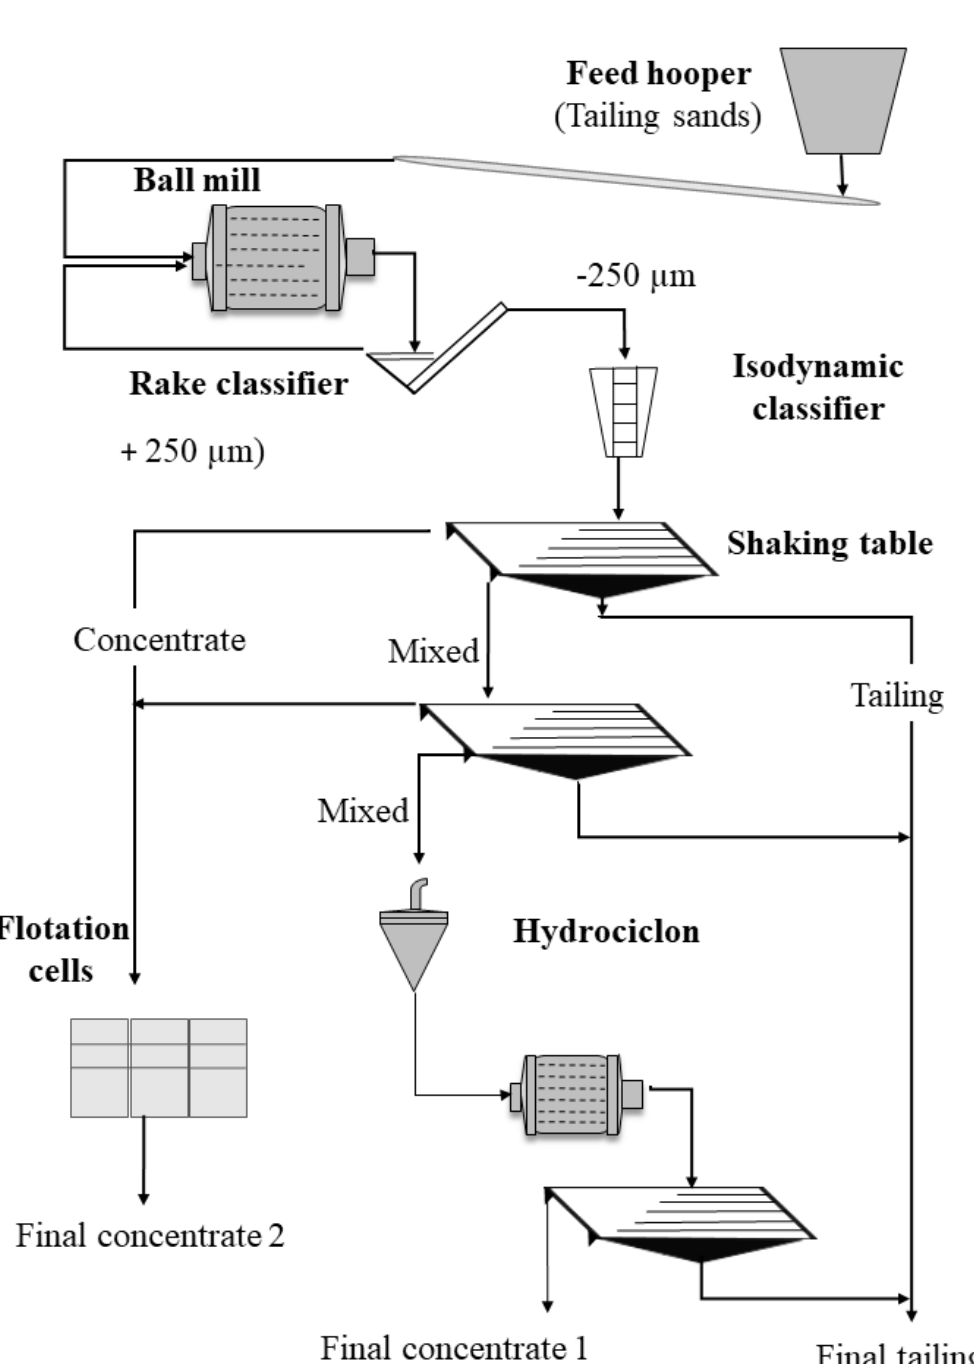
Figure 2. Simplified flux diagram followed by the samples used in this study in the Catavi processing plant.